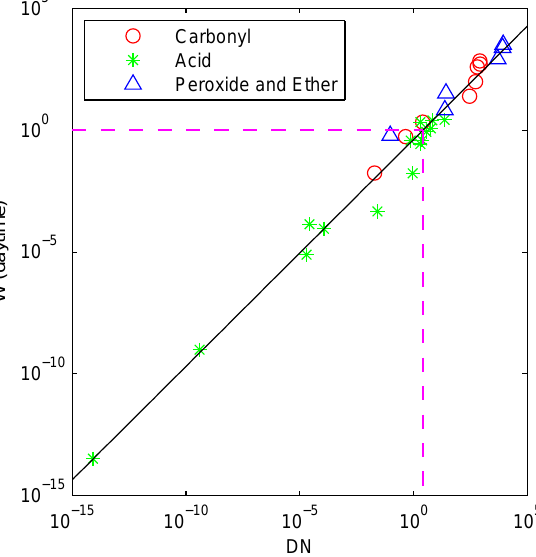
Fig. 7. The ratio of the rate of gas phase OH oxidation to the rate of aqueous phase oxidation, W as a function of the di- ( LWC v · R · T · k H ) − 1 for the se- mensionless number, DN = 1 10 ries of compounds investigated under daytime OH concentrations in an air parcel with a LWC = 0.5gm − 3 at 298K. The magenta dashed line indicates the transition between gaseous reactions be- ing more important, DN (cid:29) 1 and aqueous reactions being more im- portant, DN (cid:28) 1. Similar plots with nighttime OH concentrations Fig. 6. The ratio of the rate of gas phase OH oxidation to the rate of and LWC = 0.001gm − 3 are shown in the Supplement and yield an aqueous phase oxidation for a series of acids in an air parcel with a identical DN liquid water content of 0.5gm − 3 at 298K. Labeled rectangles are (defined as the moles of OH / C aqueous bound by differences in C gas OH OH per volume of air/the moles of OH per volume of liquid) during different times of the day and the pH of the cloud or fog droplet ranging between 2 and 6. The line demarcating OH at Henry’s law equilibrium is shown on the left side of the plot. Species are labeled in order of increasing W at pH = 6: (1) tartaric acid (R,R), (2) malic acid, (3) malonic acid, (4) lactic acid, (5) succinic acid, (6) pyru- vic acid, (7) formic acid, (8) propanoic acid, (9) glyoxylic acid, (10) 2-methyl propanoic acid, (11) pentanoic acid, (12) hexanoic acid, (13) acetic acid, (14) 3-methyl butanoic acid, and (15) 2,2- dimethyl 1-propanoic acid.